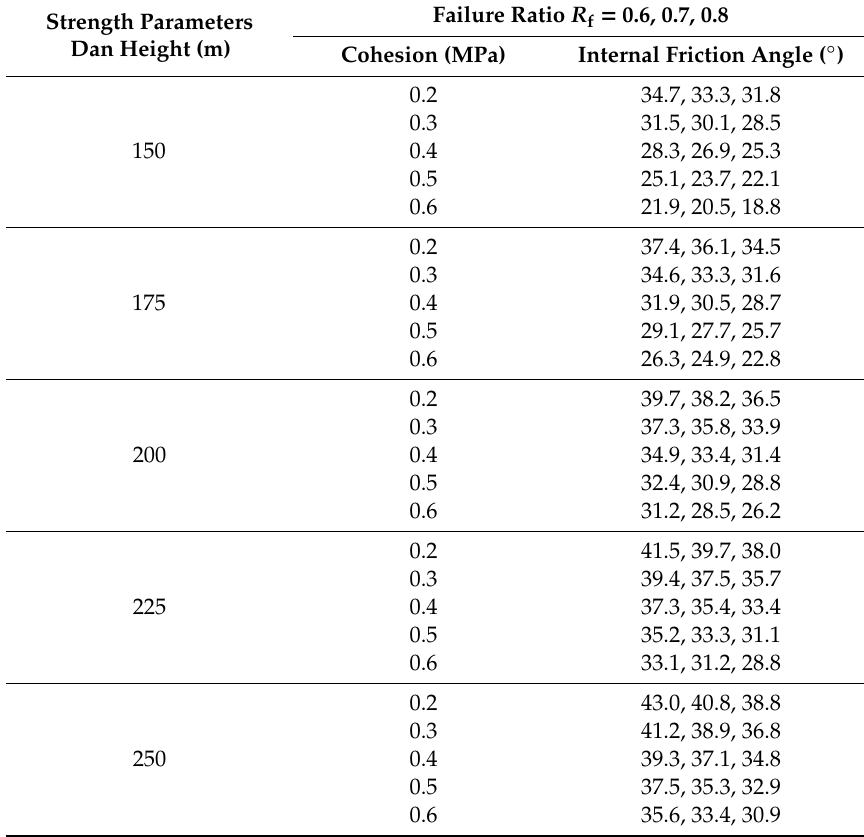
Figure 15. Reasonable value ranges for the failure ratio, cohesion, and internal friction angle of ACC that comprehensively meet YSFCS under di ff erent dam heights. Table 5. Failure ratio, cohesion, and internal friction angle minimums of ACC that comprehensively meet YSFCS with di ff erent dam